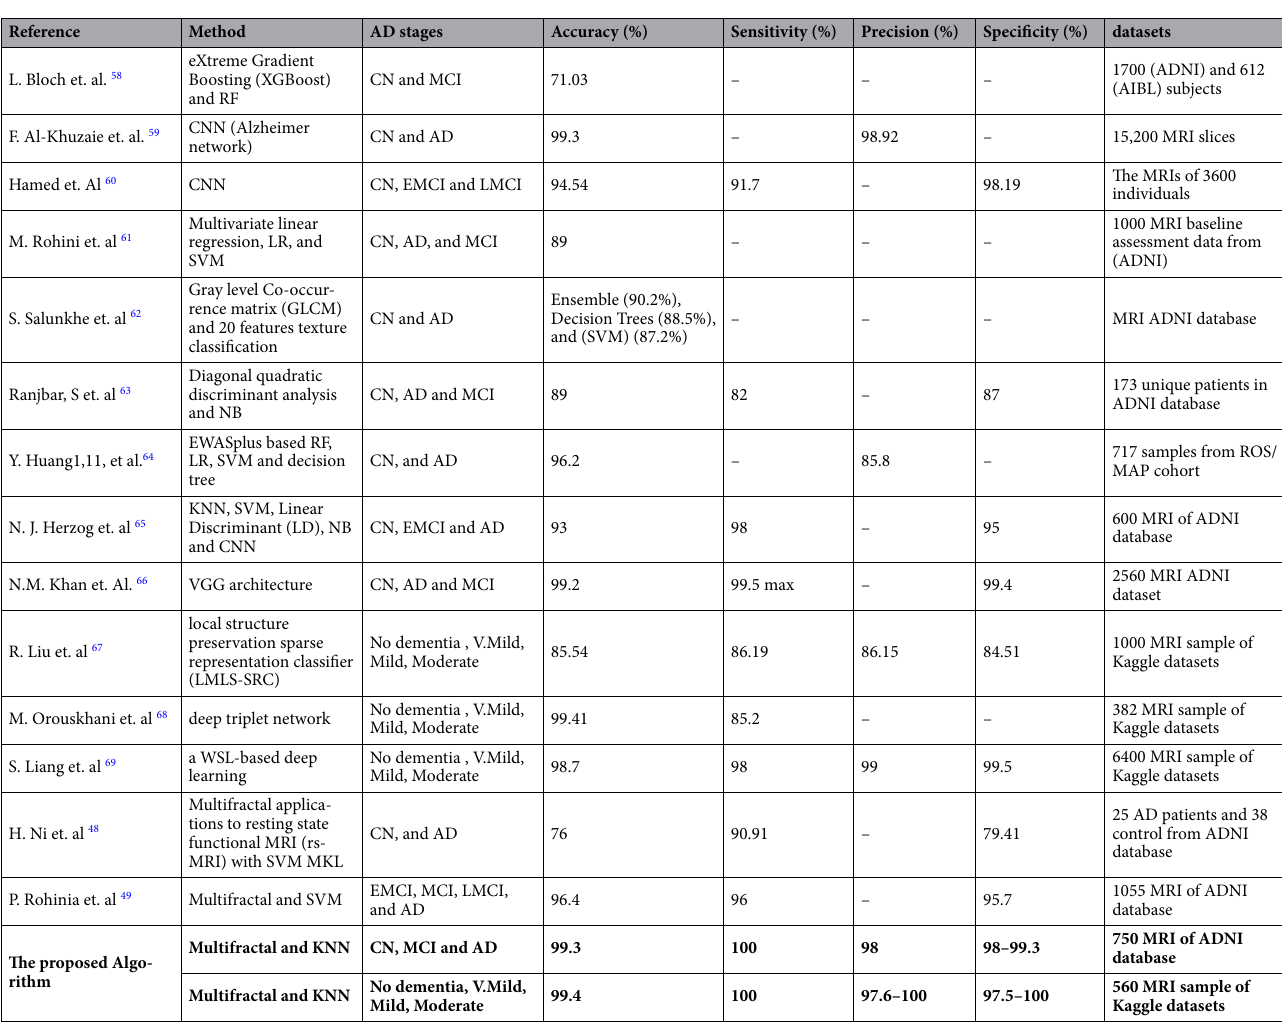
Table 8. Classification techniques evaluation. where, EMCI early mild cognitive impairment, LMCI late mild cognitive impairment, NB naïve bayes, LR logistic regression, RF random forest, MKL multiple kernel